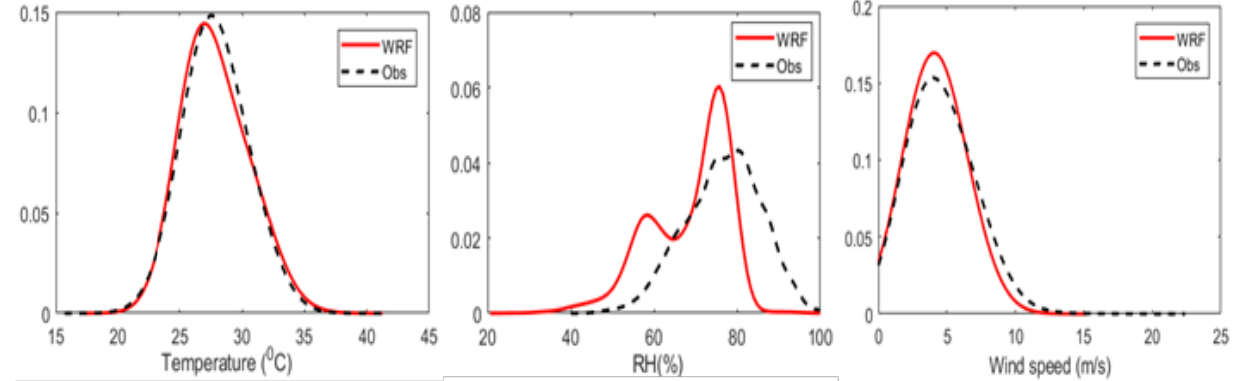
Figure 5. Kernel density estimates of ( left ) daily maximum temperature, ( middle ) relative humidity, and ( right ) wind for historical simulation period (2008–2012) for every LRS for observations and WRF simulation.